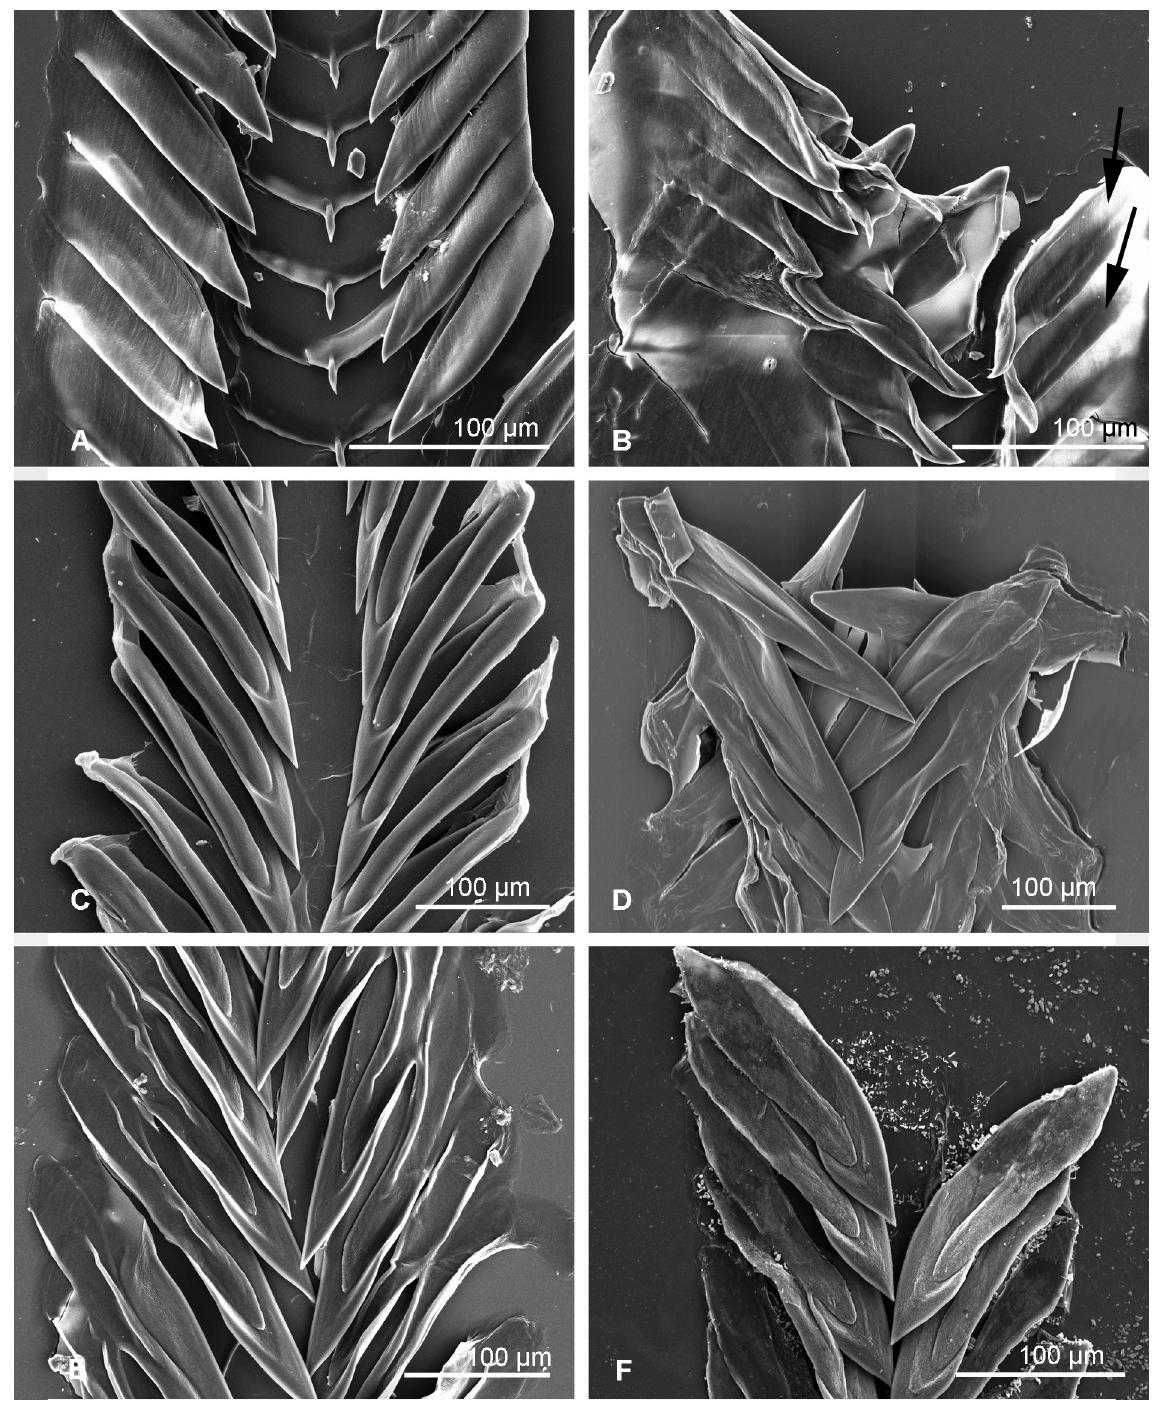
Fig. 11. Radulae of species of Sibogasyrinx Powell, 1969 and Leucosyrinx Dall, 1889. A–B . Sibogasyrinx clausura sp. nov., MNHN-IM-2009-16763. A . Central part of radula with fully formed teeth. B . Anteriormost part of radula at bending plane; marginal teeth at the right (black arrows) are unfolded due to mechanical impact. C . Leucosyrinx verrillii (Dall, 1881), French Guiana, MNHN-IM-2013-56288 (shell seen on Fig. 13C). D . Leucosyrinx sp. F, Coral Sea, MNHN-IM-2007-17846 (shell seen on Fig. 13K). E . Leucosyrinx sp. G, Papua New Guinea, MNHN-IM-2009-17089 (shell seen on Fig. 13D). F . Leucosyrinx sp. C, Solomon Islands, MNHN-IM-2007-42503 (shell seen on Fig.